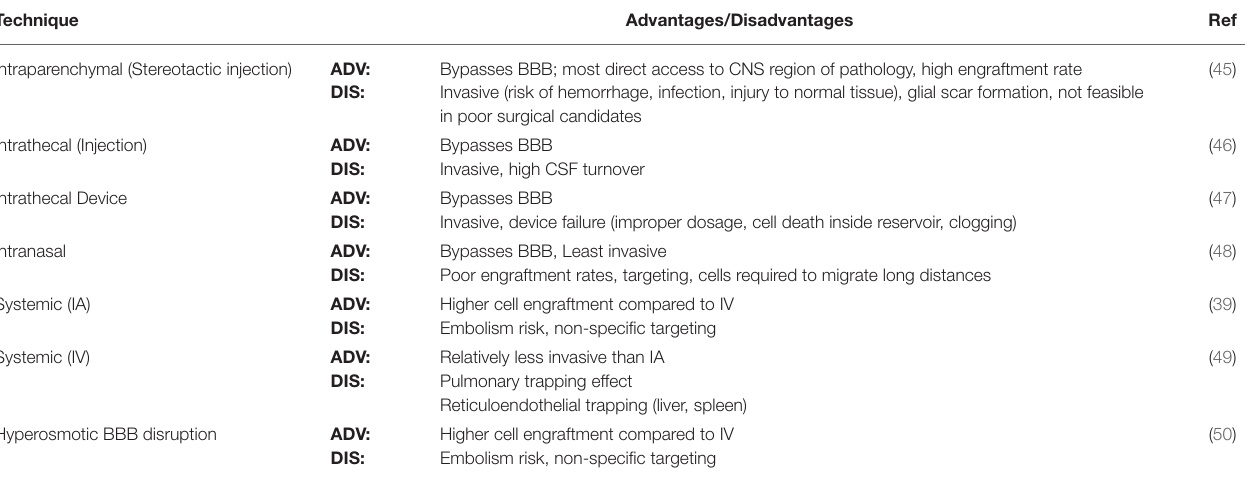
TABLE 1 | Administration routes for intracerebral cellular therapy. Technique